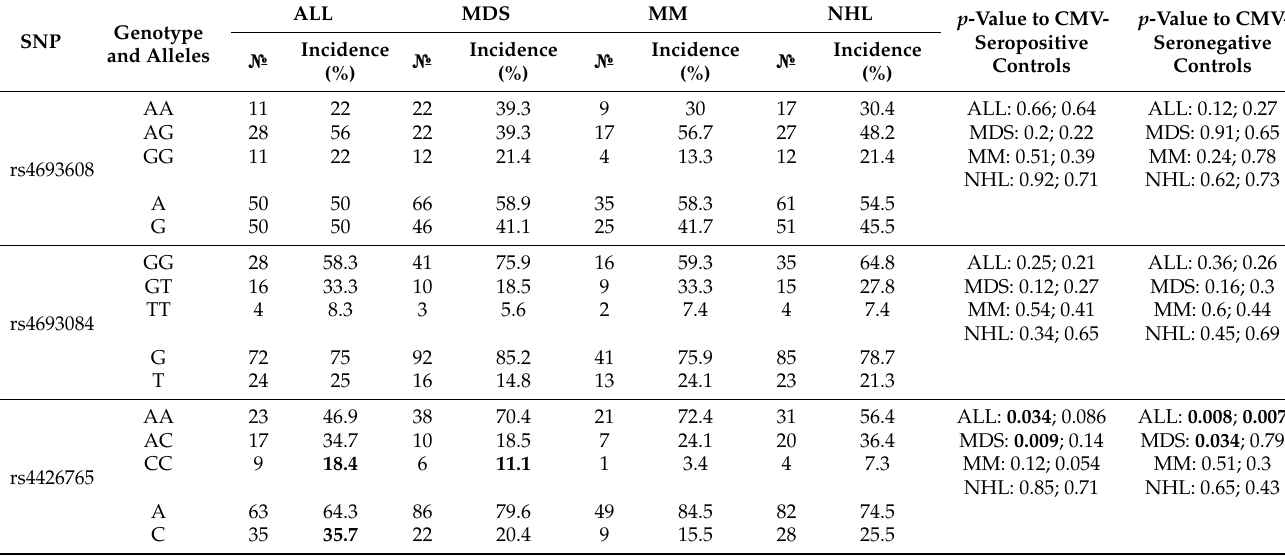
Table 4. Genotype and allele frequencies of the HPSE gene SNPs in CMV seropositive patients with hematological malignancies.